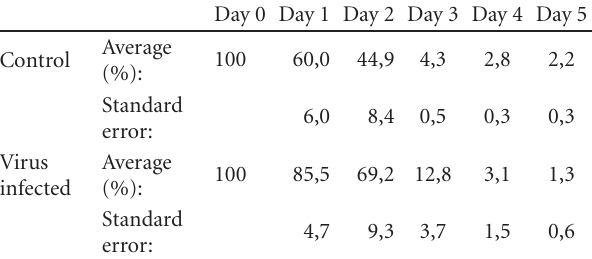
Table 1: This table shows the survival of noninfected and virally infected cells from day 0 to day 5. It can be seen that virally infected cells exhibit slightly better survival than noninfected cells, for which the reason remains to be